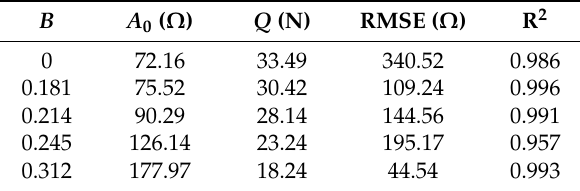
Figure 12. Resistance reduction showed by the simulation and experimental data at different force applied. Table 4. Values of parameters at various magnetic fields based on Equation (2).